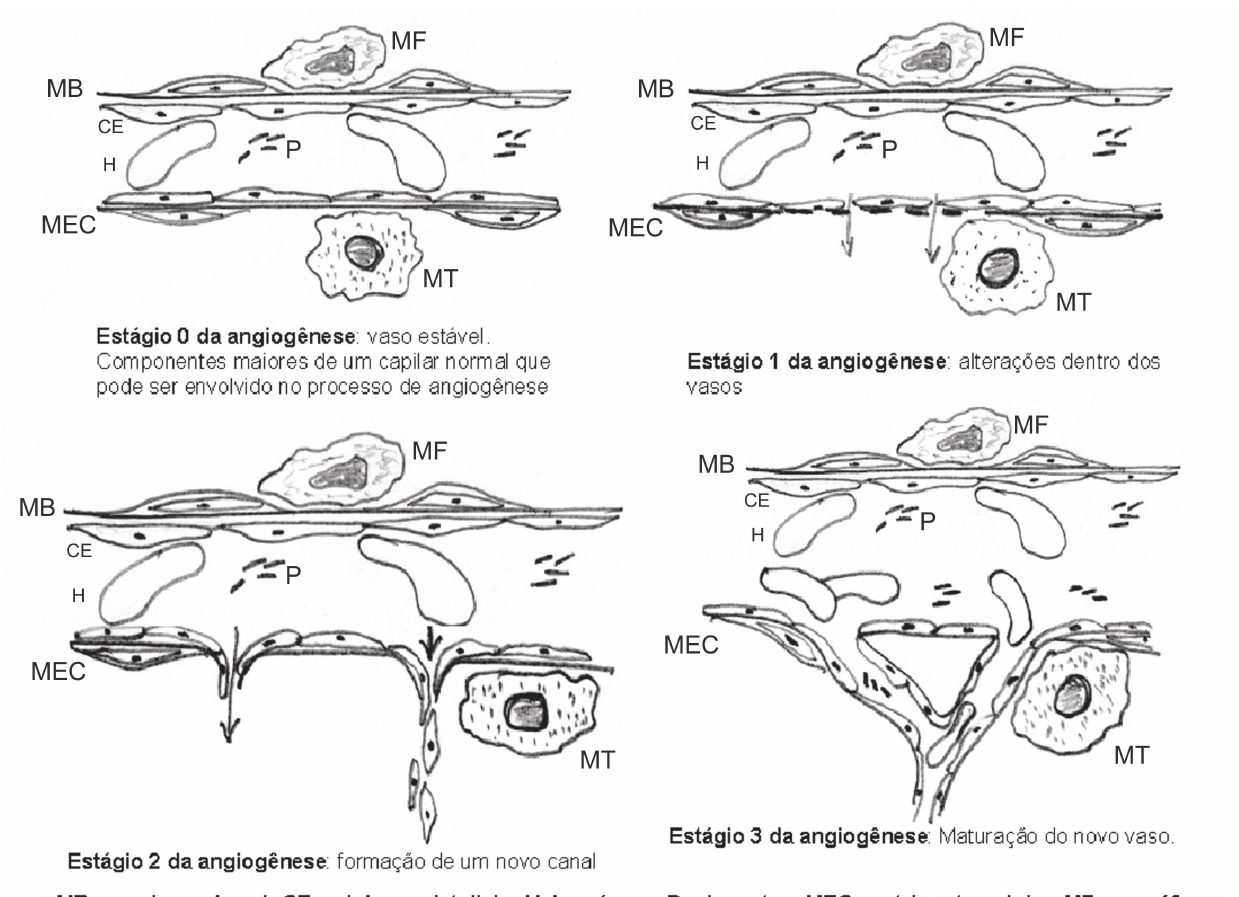
Fig. 2 – Mobilização de células progenitoras endoteliais para neovascularização. Adaptado de Murasawa et al.